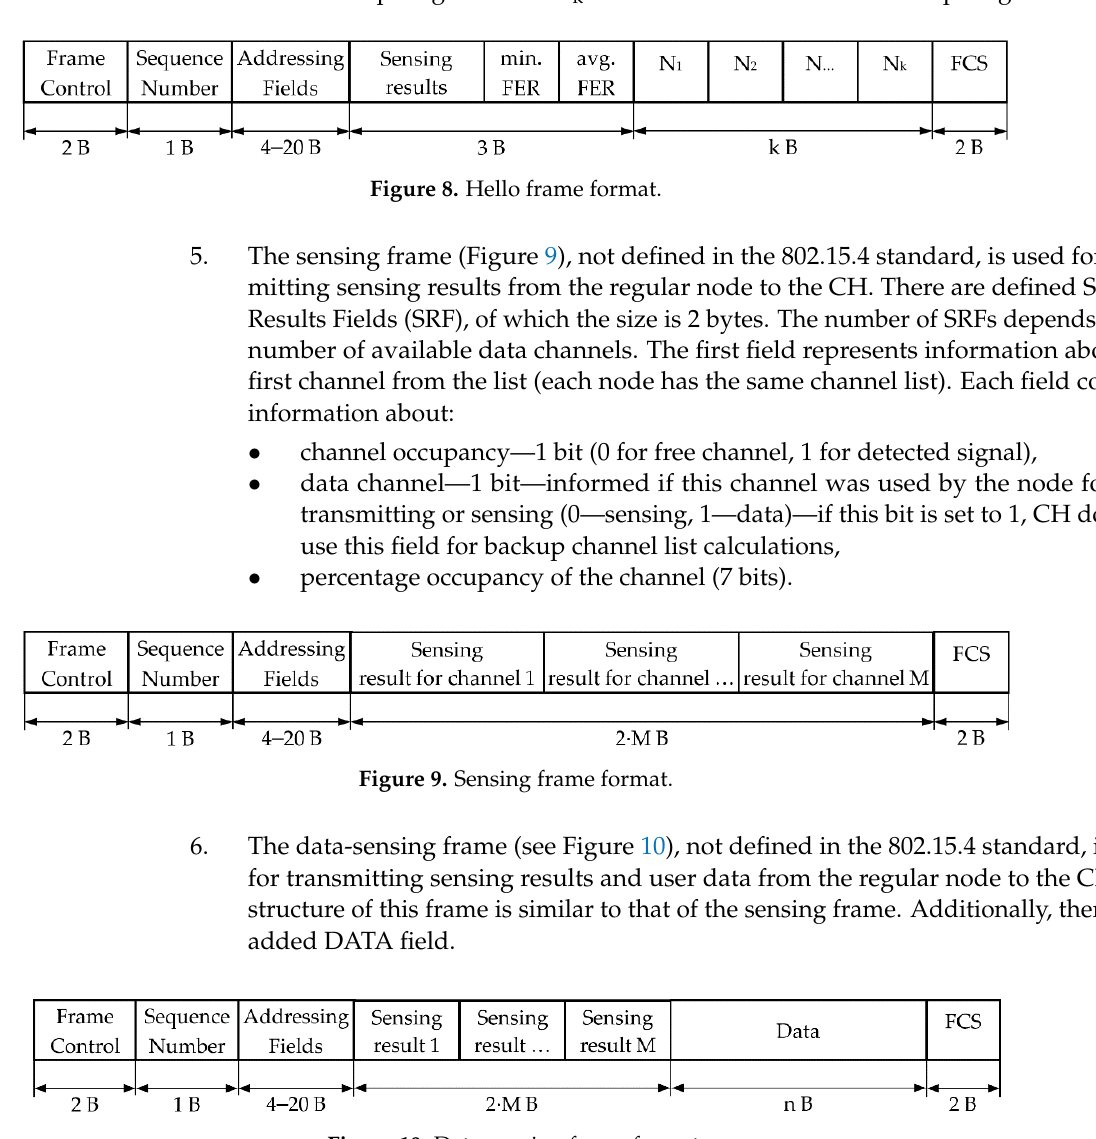
Figure 10. Data-sensing frame format.